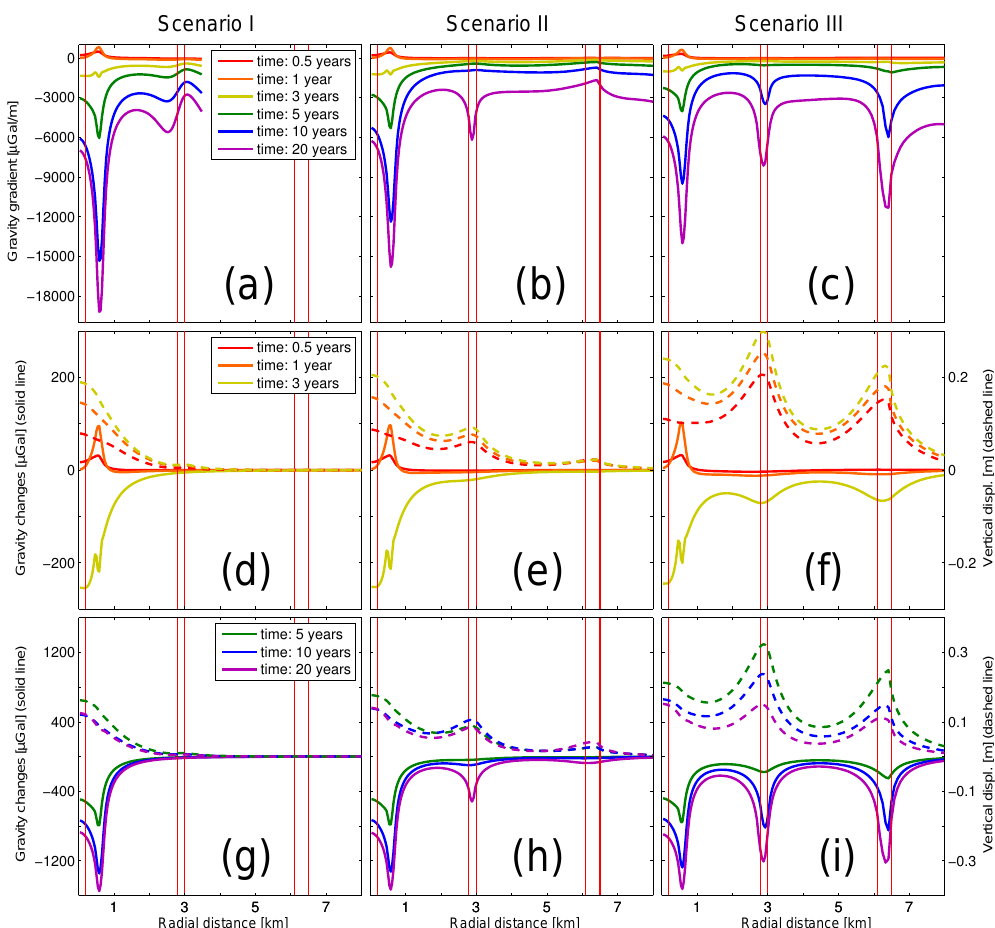
Figure 13. (a, b, c) (residual) gravity gradient (cid:49)g/v on the surface after t = 0 . 5, 1, 3, 5, 10 and 20 years of unrest for Scenarios I, II and III. The respective (residual) gravity changes (cid:49)g (solid lines) and vertical deformation v (dashed lines) are reported in double y axis plots for t = 0 . 5, 1 and 3 ( d, e, f ) and t = 5, 10 and 20 ( g, h, i ) years of unrest. Vertical lines refer to the boundary of the central conduit and to the injection and shallowest points of faults. In Scenario I we observe that the gravity gradient starts to oscillate at r ∼ 2500m. This behaviour is a purely numerical artefact, since for r > 2500m the uplift approaches to zero and the gravity gradient becomes singular. For this reason the plot is limited to 0 < r < 3500m. For the interpretation of the legend the reader is referred to the colour version of the